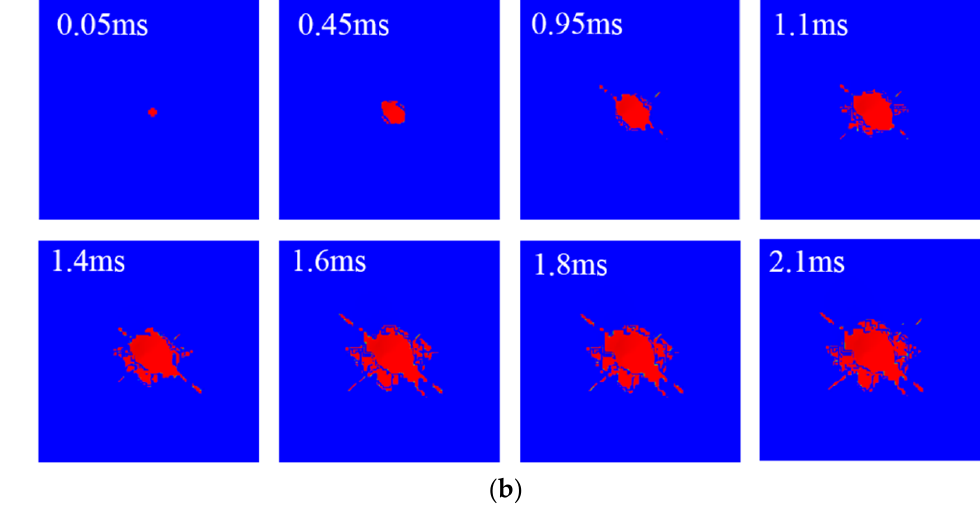
Figure 7. Intra ‐ laminar failure of the laminate. ( a ) Fiber failure zone (red zone). ( b ) Matrix failure zone (red zone).